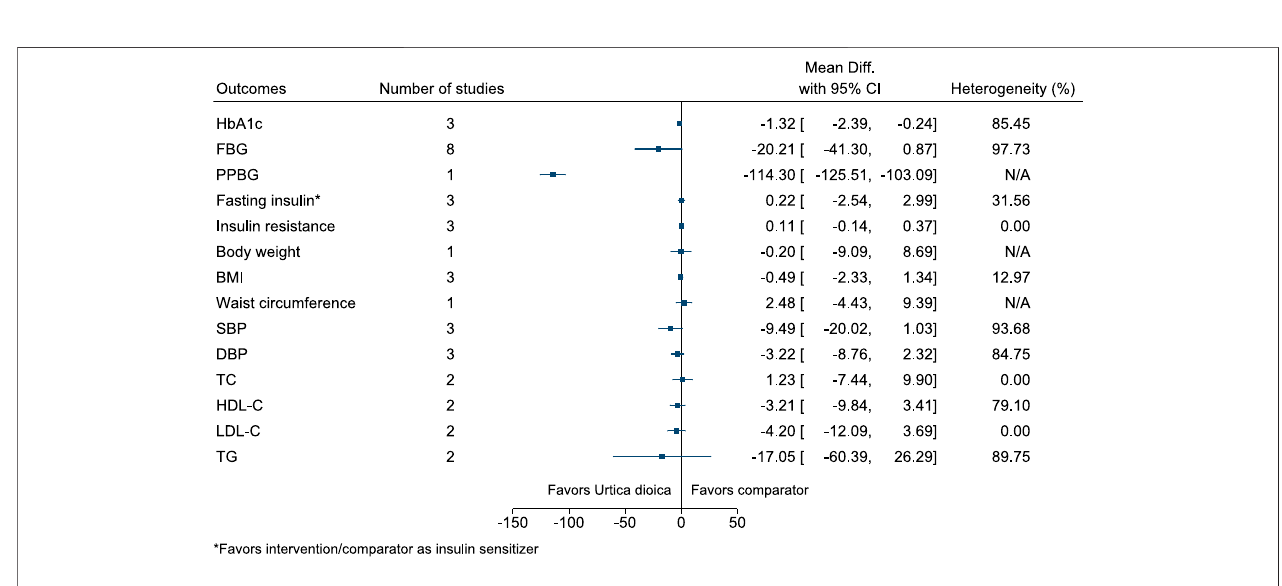
FIGURE 35 | Urtica dioica — Summary forest